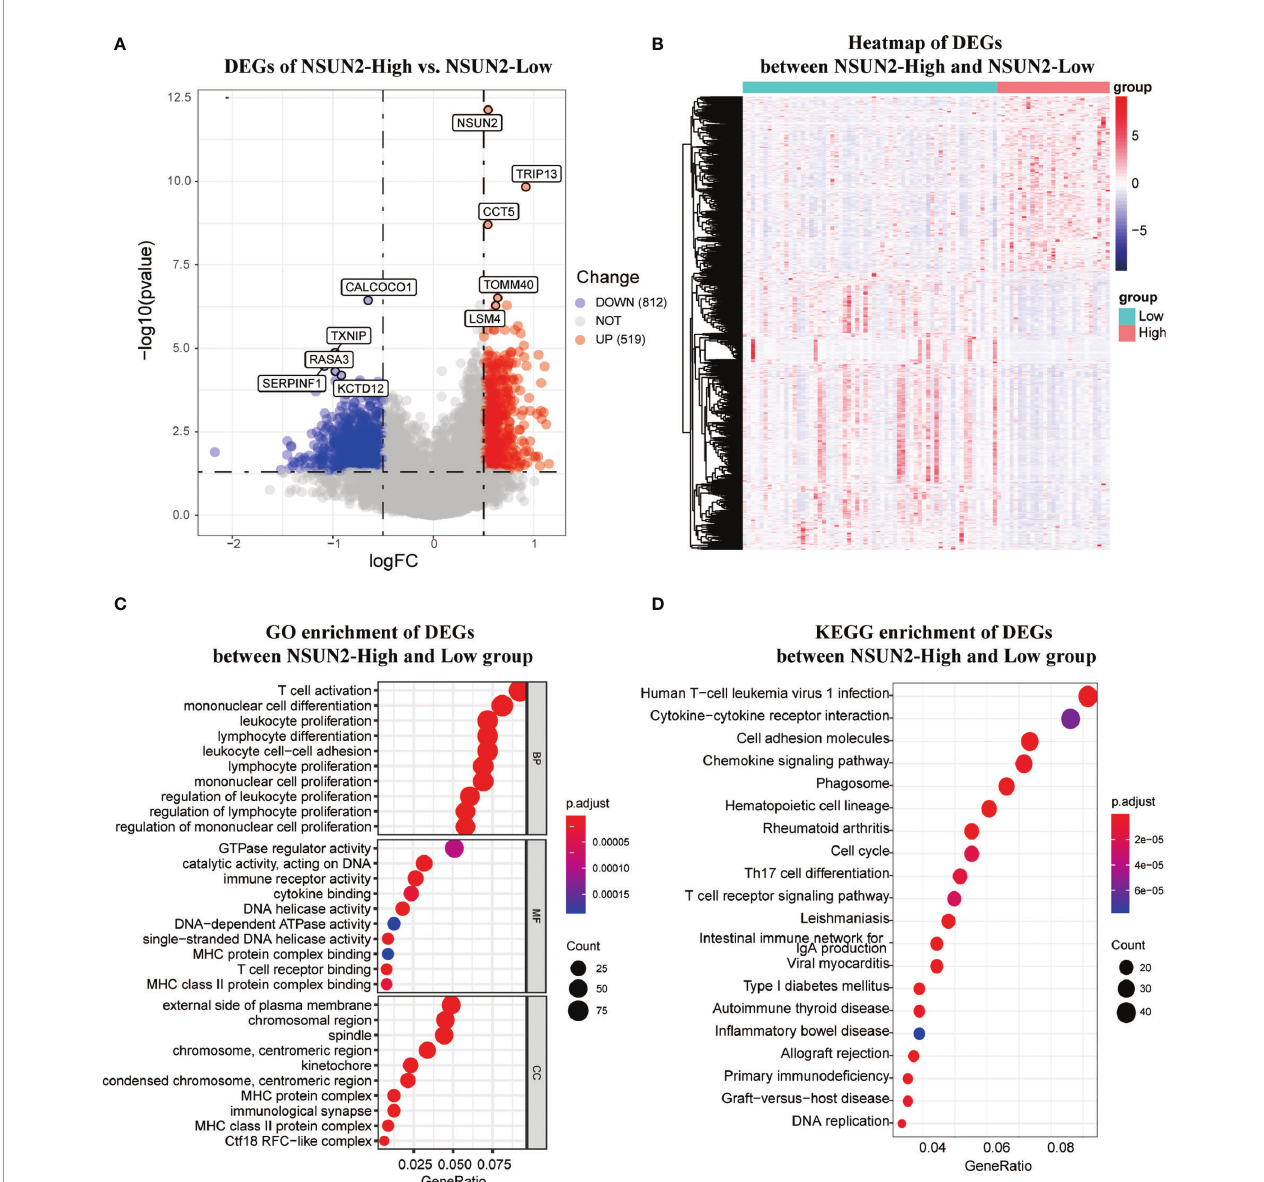
FIGURE 5 | The differentially expression analysis of samples with NSUN2 high and low expression. (A) The volcano plot of DEGs between the NSUN2 high expression and low groups. Red points mean upregulated genes, and blue points means downregulated genes. The top 5 signi fi cant differential expressed genes were notated. (B) The heatmap of DEGs between the NSUN2 high and low expression groups. The GO enrichment (C) and KEGG enrichment (D) analysis of the DEGs between the NSUN2 high and low expression